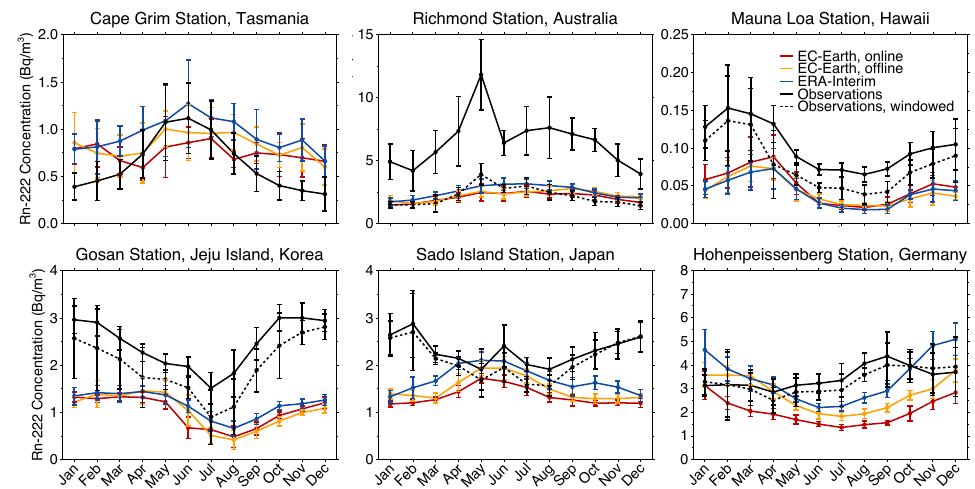
Figure 3. Comparison of monthly mean surface radon-222 concentrations from the online and offline EC-Earth simulations (solid red and orange lines, respectively) and the ERA-Interim simulation (solid blue lines) against surface measurements (black lines). The observational means shown by the dashed lines only include the measurements made within a certain station dependent diurnal window (see Table A2).